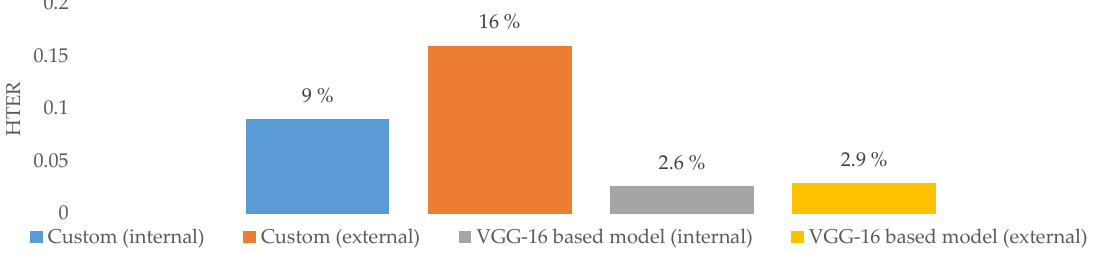
higher the better).